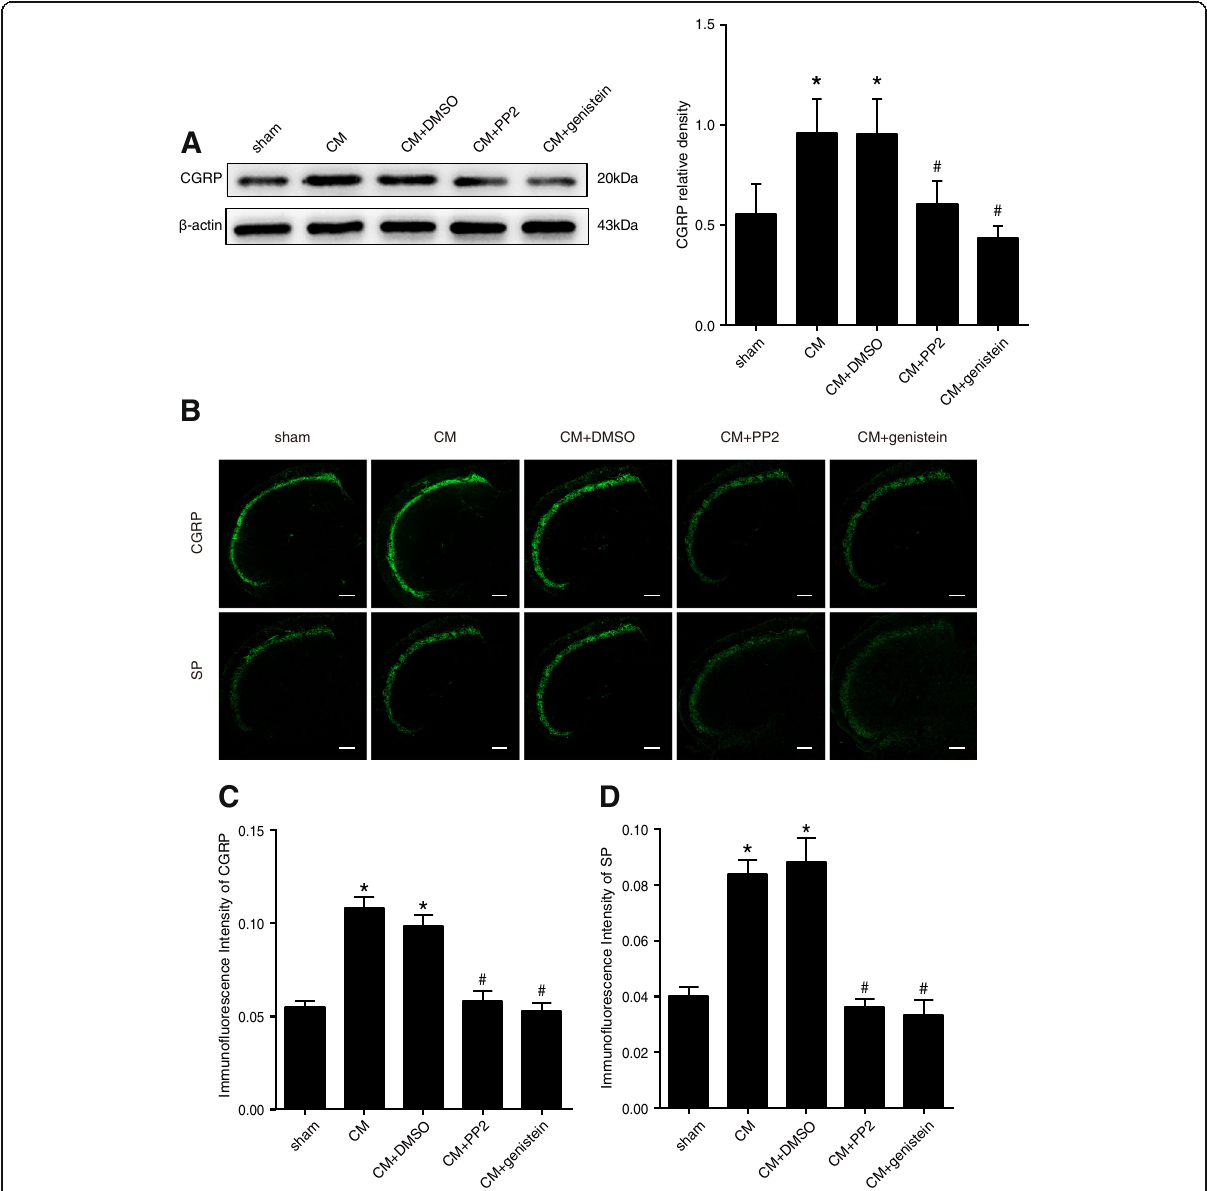
Fig. 5 Expression levels of CGRP in the TNC and immunofluorescence staining for CGRP and SP in the TNC. a The expression of CGRP was significantly increased in the CM group compared with that in the sham group, and no significant difference in the expression of CGRP was found between the CM and CM + DMSO groups. The expression of CGRP in CM rats was significantly decreased after the administration of PP2 and genistein ( n = 6 in each group, five images per animal, * P < 0.05 compared with the sham group, #P < 0.05 compared with the CM + DMSO group). b The bilateral immunoreactivity of CGRP and SP in the TNC was investigated by immunofluorescence staining (the image shows only one side because no difference was found between the two sides). c The fluorescence intensities of CGRP in the TNC were elevated in the rats belonging to the CM groups compared with those in the sham group, and no significant difference in the expression of CGRP was found between the CM and CM + DMSO groups. PP2 and genistein treatment decreased the CGRP fluorescence intensities. d The fluorescence intensities of SP in the TNC were elevated in the rats of the CM groups with those in the sham group, and there was no significant difference in the expression of SP between the CM and CM + DMSO groups. PP2 and genistein treatment decreased the SP fluorescence intensities ( n = 6 in each group, * P < 0.05 compared with the sham group, # P < 0.05 compared with the CM + DMSO group, scale bar = 200 μ